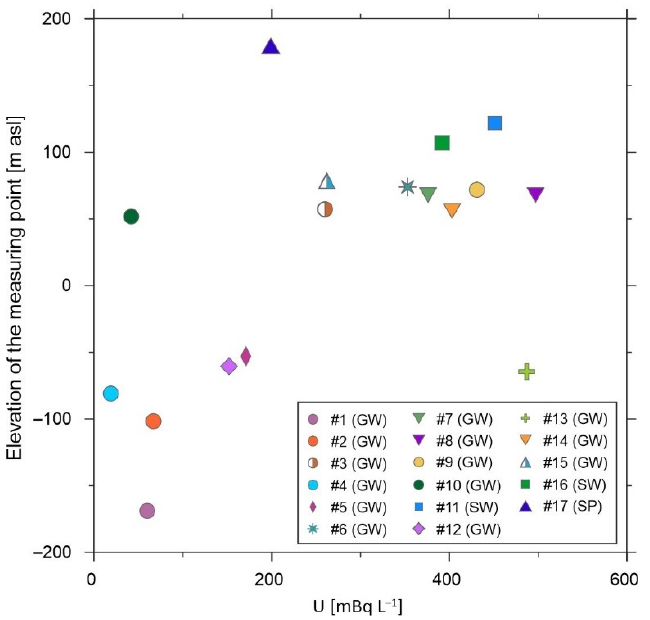
Figure 6. Measured Σ U activity concentration values plotted against the elevation of the measuring points (i.e., elevation of screening in wells or surface topography in case of lakes and springs).